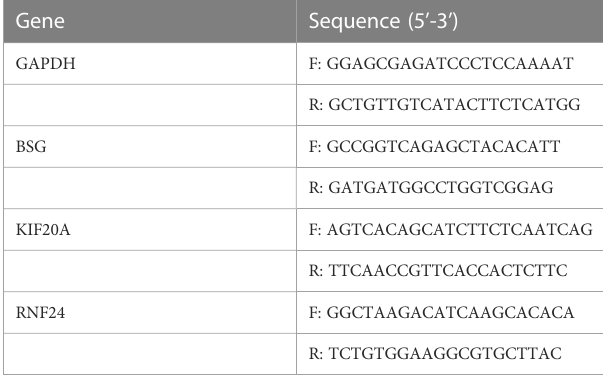
TABLE 1 Primer sequences used for